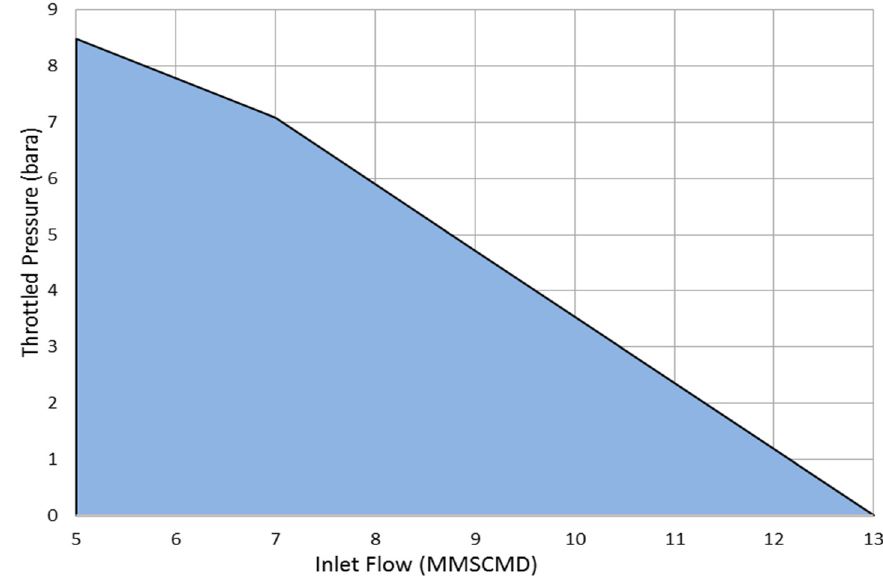
Figure 14. Predicted throttled pressure with suction throttling controller.